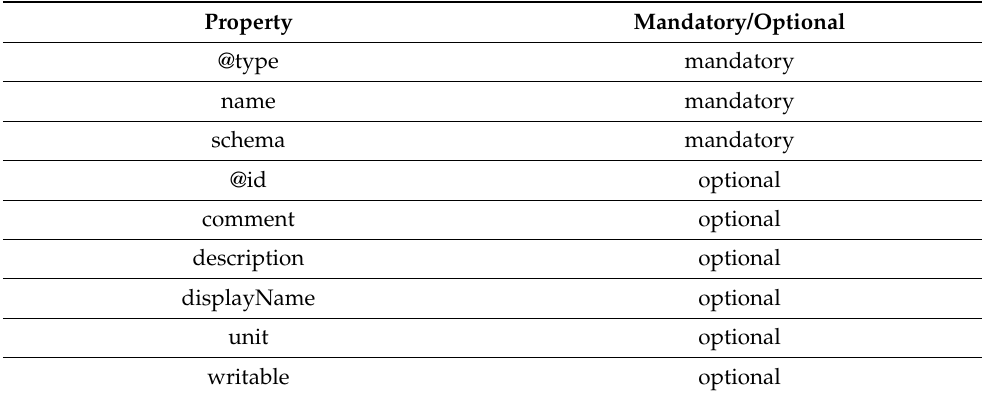
Table 7. Properties of the Property class.